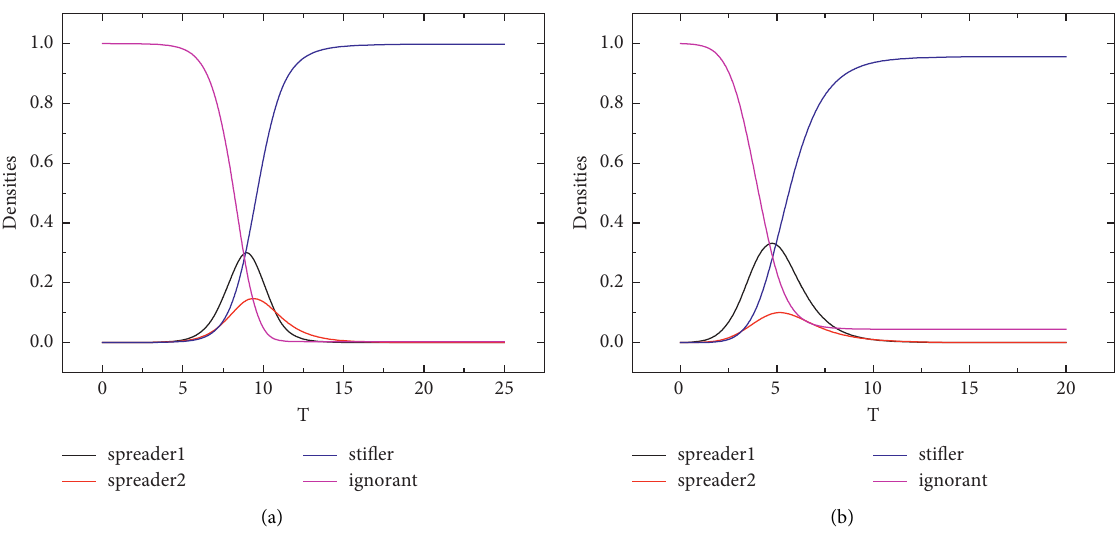
Figure 2: Density of four categories of people in different networks. (a) WS small-world network. (b) BA scale-free network.